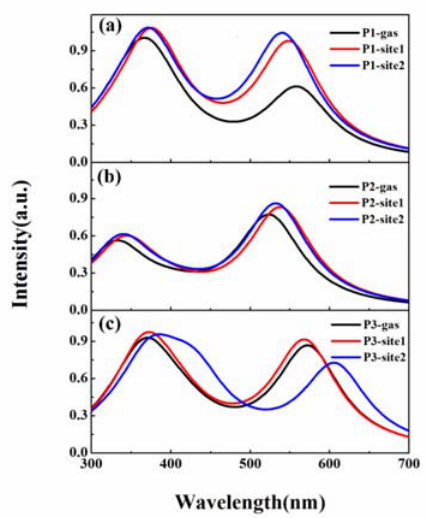
Figure 4. One-photonabsorption(OPA)spectrafor( a )P1, ( b )P2, and( c Figure 4. One ‐ photon absorption (OPA) spectra for ( a ) P1, ( b ) P2, and ( c ) P3 in different microenvironments.